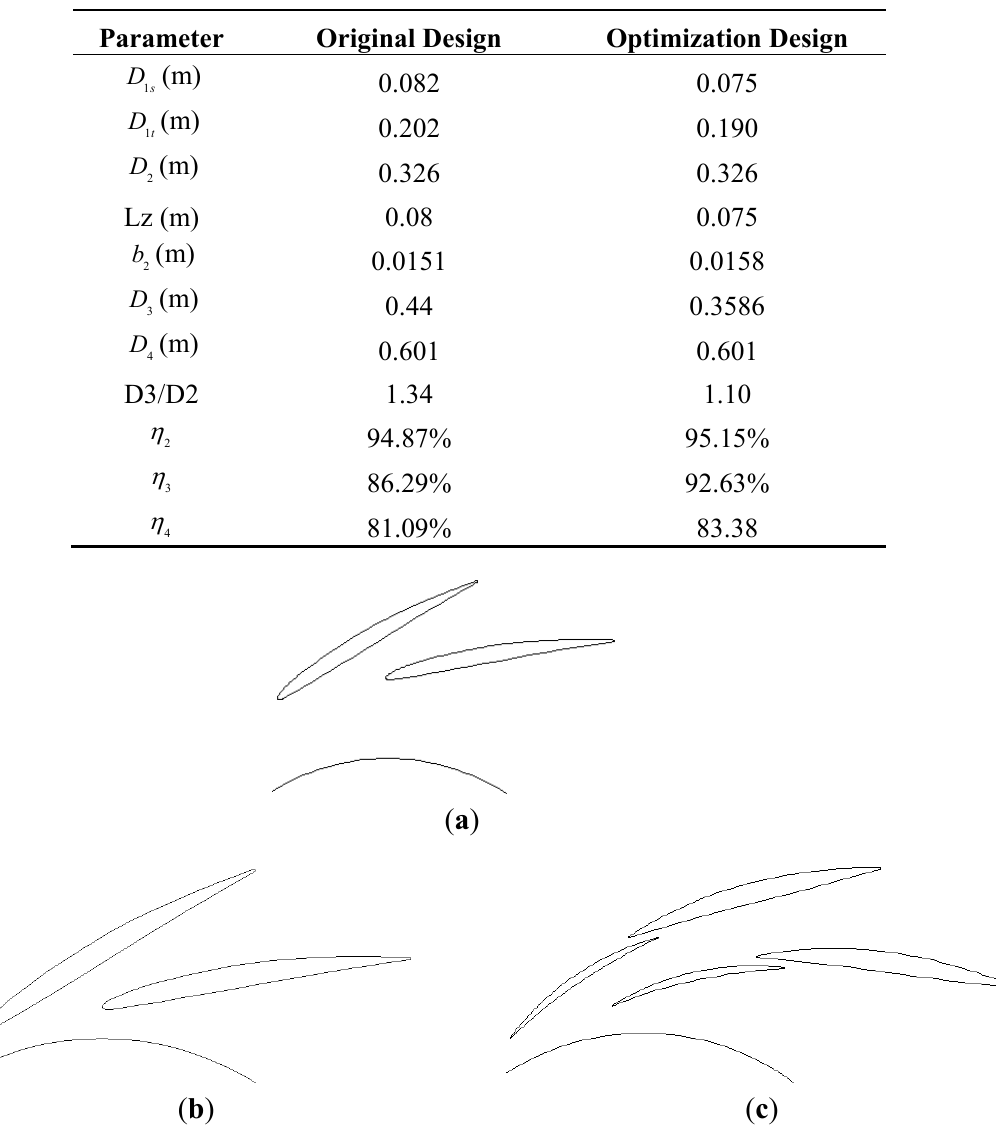
Table 3. Parameters comparison between the optimization design and the original design.